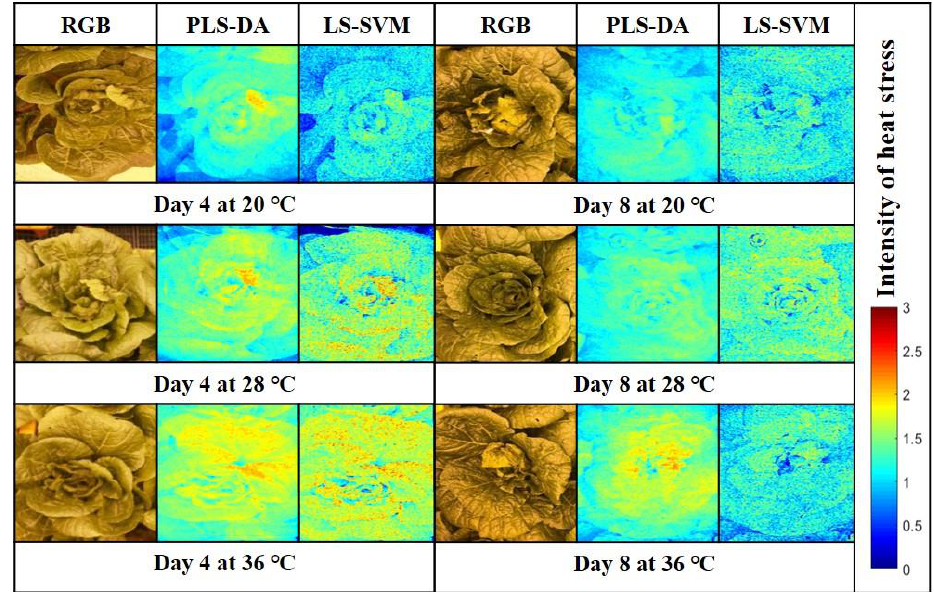
Figure 5. Red, green, and blue (RGB), partial least squares-discriminant analysis (PLS-DA), and least-squares support vector machine (LS-SVM) model images of Chinese cabbage samples grown at 20 °C, 28 °C, and 36 °C for 4 and 8